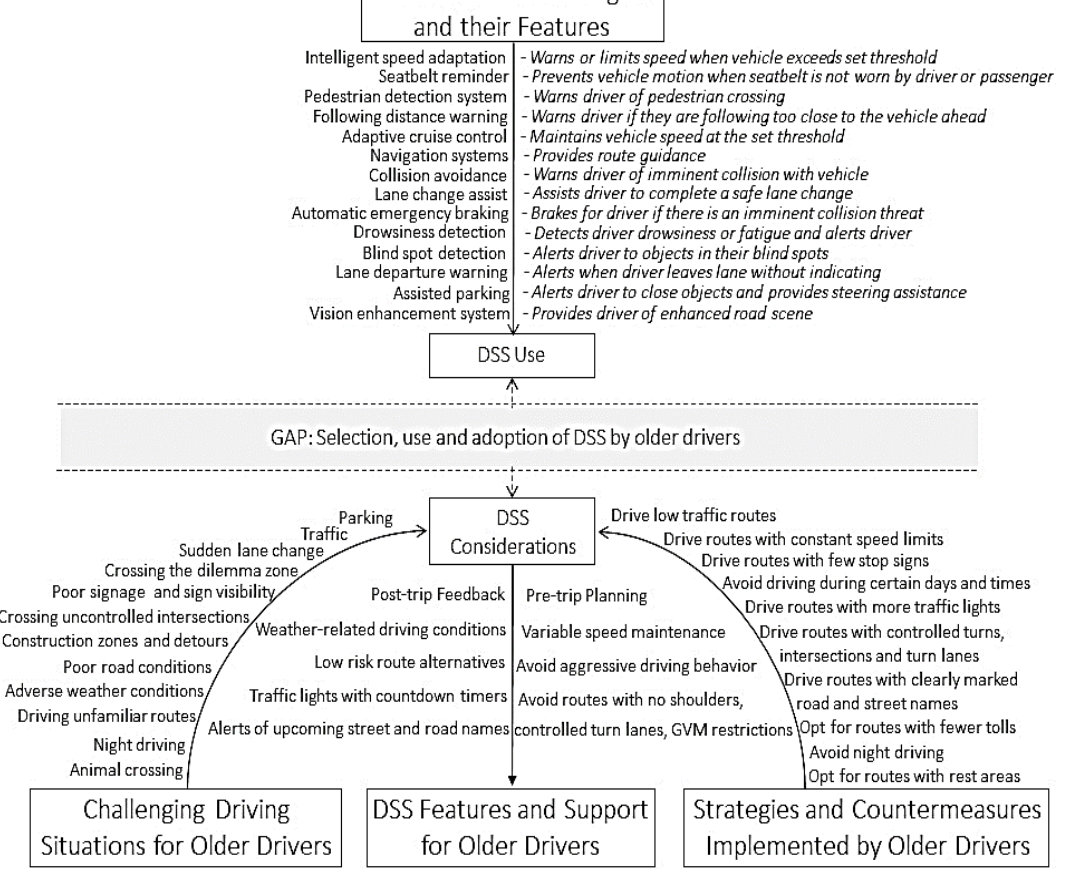
Figure 3. Framework for highlighting the current driver support systems (DSS) technologies that can help address the driving safety challenges of older drivers.